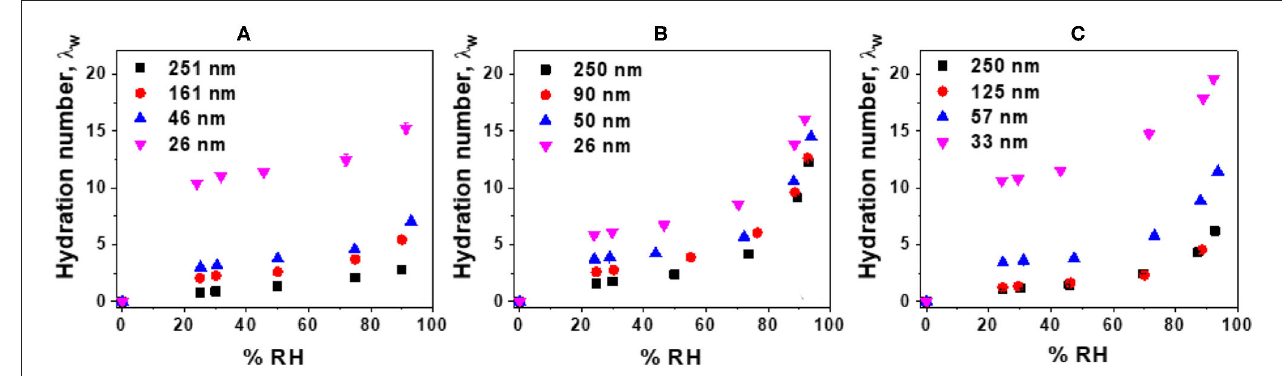
FIGURE 3 | Corrected hydration numbers ( λ w ) (with error bars) as a function of %RH: (A) Nafion, (B) LS 1.6, and (C) LS 3.1 films deposited on SiO 2 /Au crystal.